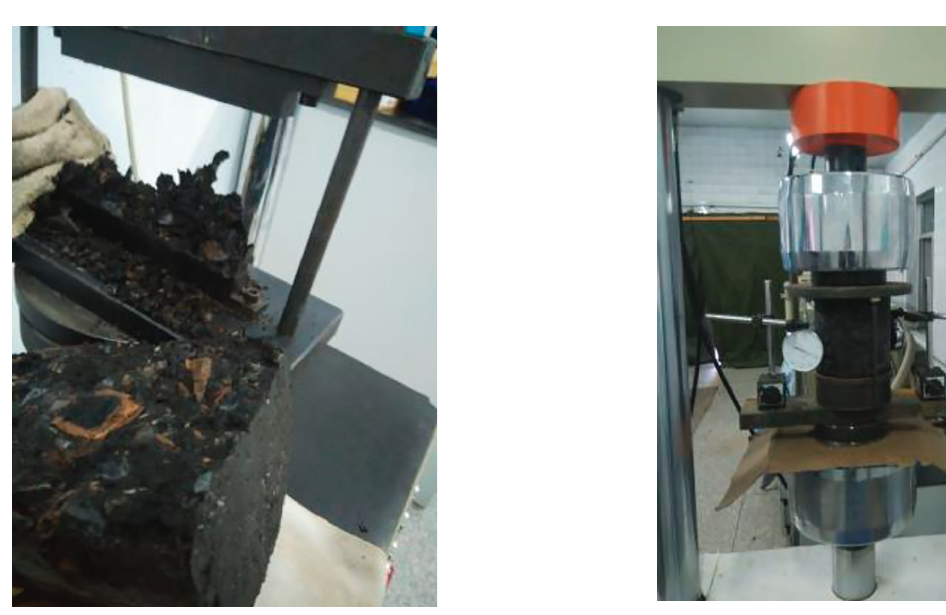
Figure 11: Splitting tensile strength test. Figure 12: Compressive resilient modulus